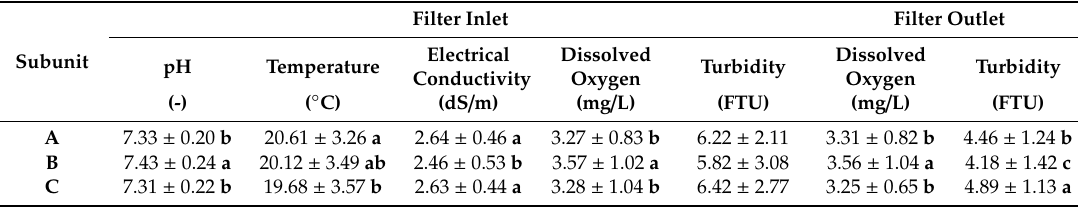
Table 1. Average ± standard deviation of the main physical and chemical parameters of wastewater before and after being filtered. Di ff erent letters mean that there were significant di ff erences ( p < 0.05) in the values of each parameter. Filter Subunit